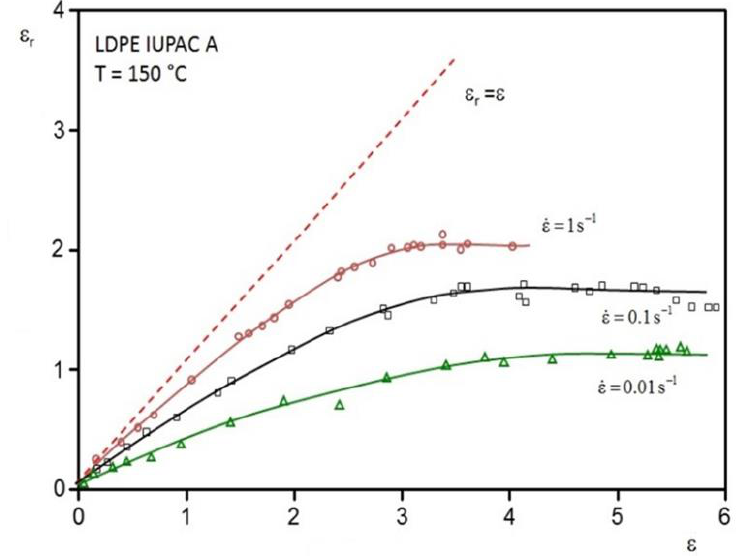
Figure 2. Recoverable elongation 𝜀 𝑟 as a function of the total elongation 𝜀 in experiments at constant elongational rates 𝜀̇ and a temperature of 150 °C for a low-density polyethylene (LDPE). The experiments were performed with the Meissner oil bath rheometer. Each symbol corresponds to one sample stretched to a definite total elongation and then recovered after cutting into pieces [13].